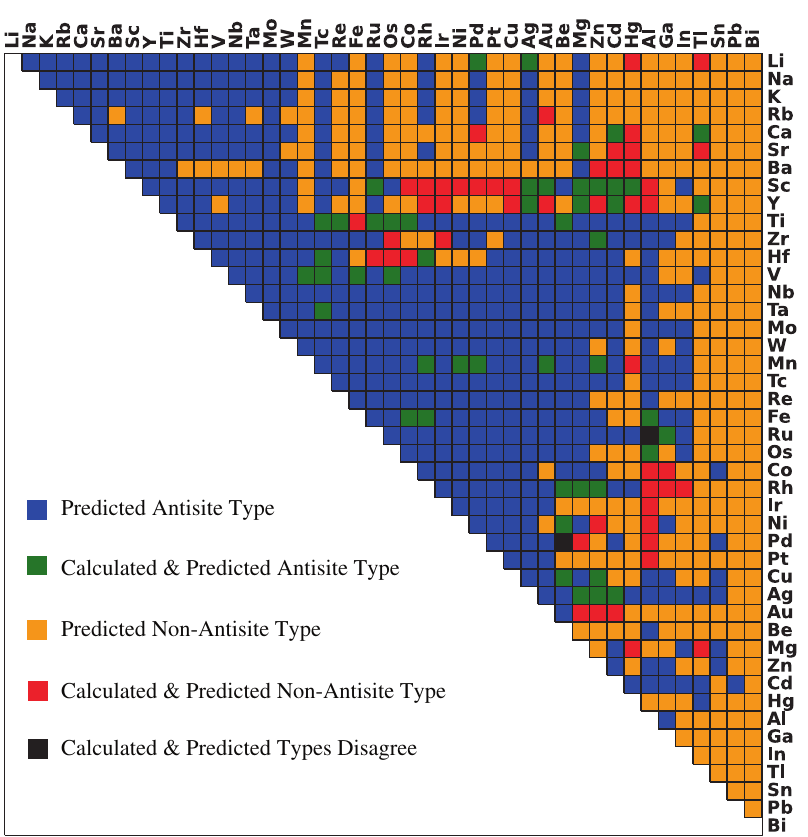
Fig. 5 Dominant defect type predictions from r-MART model for 946 B2-type intermetallics. Colors indicates the relationship between prediction and calculations as shown in the